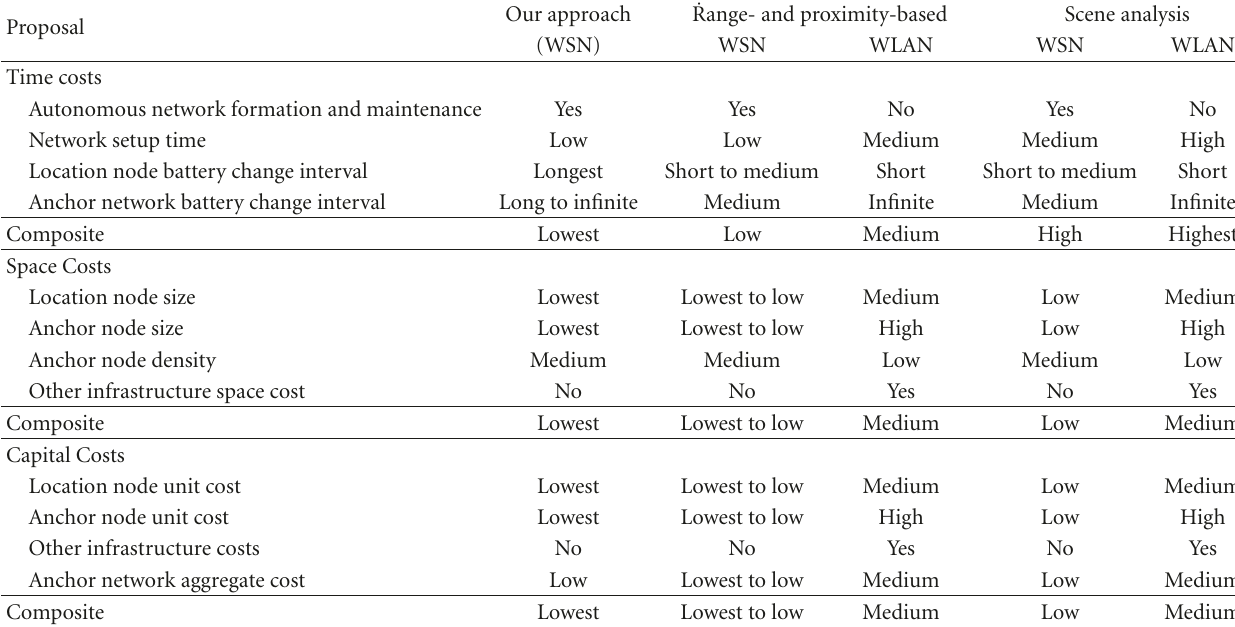
Table 4: Costs of compared localization